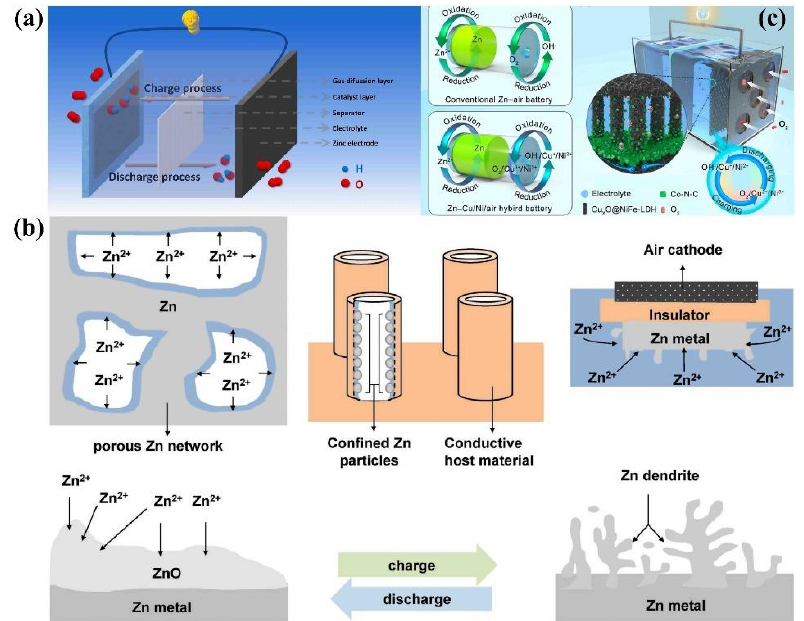
Figure 2. ( a ) Schematic charging and discharging processes of zinc-air batteries; ( b ) up: methods to decrease Zn dendrite growth and undesired relocation: employing a high surface area porous Zn structure; confining Zn in 3D conductive host materials; inhibition/suppression; down: mechanism of anode Zn deactivation during the ZAB charge/discharge cycle [17]. Copyright 2018, Wiley-VCH; ( c ) comparison of electrochemical mechanisms and scheme of Zn-Cu/Ni/air hybrid battery [70]. Copyright 2022, American Chemical Society.